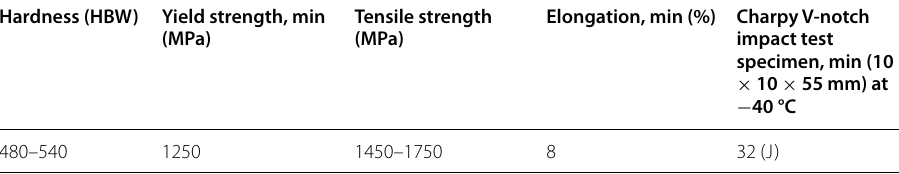
Table 2 The mechanical properties of the Armox 500T steel plate (SSAB company specification) Hardness (HBW) Yield strength, min Tensile strength (MPa) (MPa)